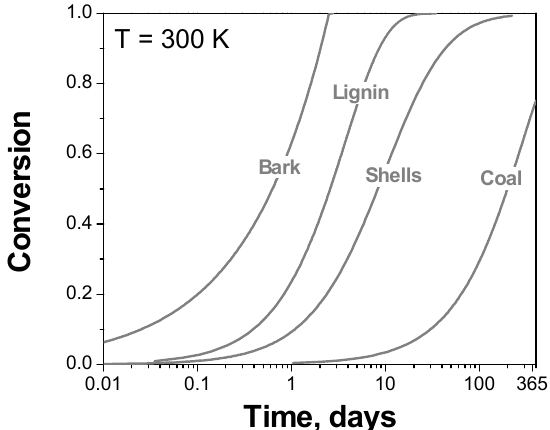
Figure 6. The use of the kinetic triplets from the original publications to predict decomposition at 27 °C for lignin [73], Shengdong coal [80], Jasminum nudiflorum Lindl. Bark [75], tea oil camellia shells [72].